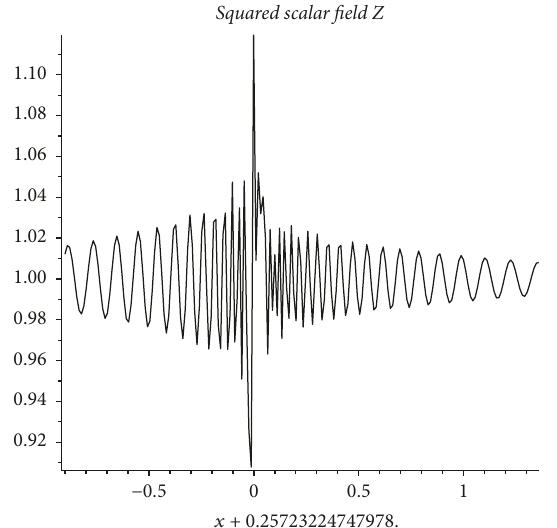
̃𝐵 = 𝑛 Figure 11: Relation of 𝐻(𝑥) = value of the Hubble constant. 𝑍(1) = 0.999329006493718 ; 535.364179666666 , 𝑘